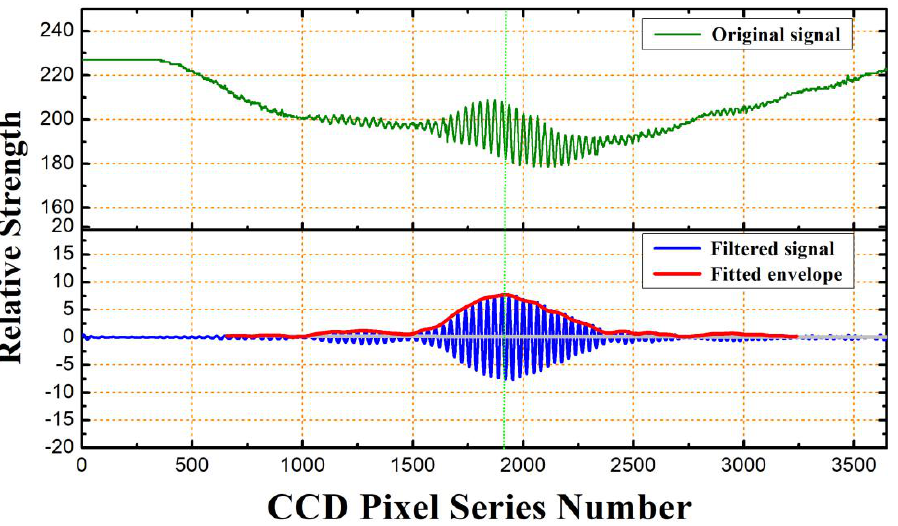
Figure 4. Peak positioning of the correlation interferometric signal.